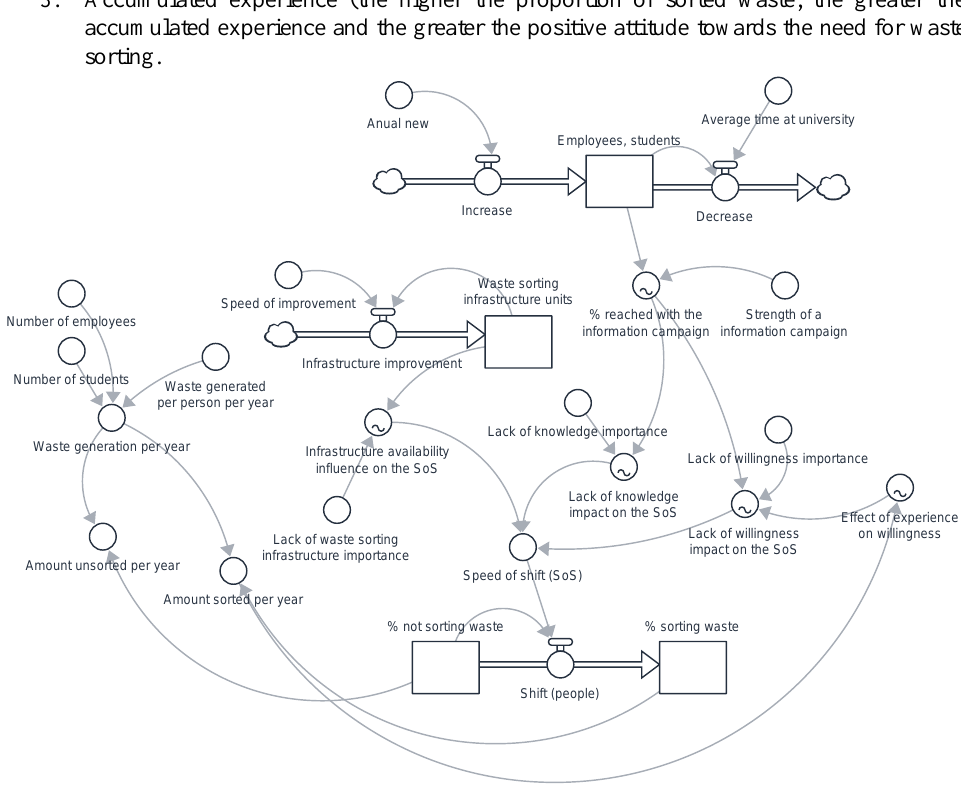
Fig. 3. Structure of the waste management module.